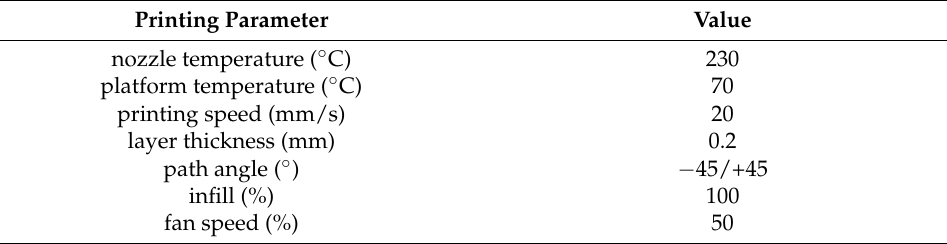
Table 1. The constant parameters of the injection molding process. Table 2. The constant parameters of the printing